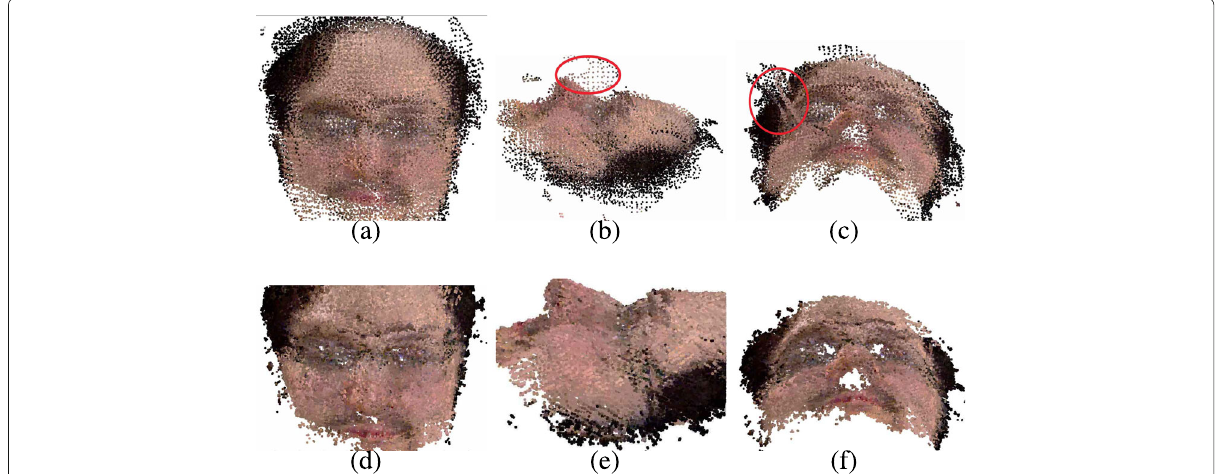
Fig. 4 Three views: ( a , b ) frontal, ( b , e ) profile and ( c , f ) side; of the point cloud of all KFs projected to a common frame before (top) and aJer optimization